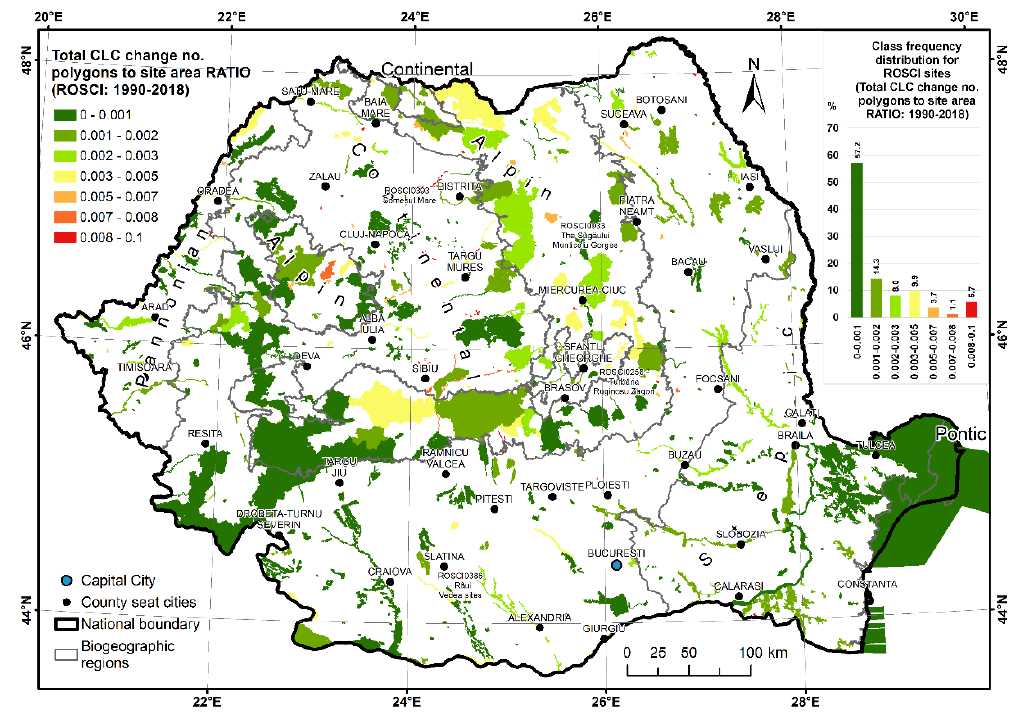
Figure 3. Changed polygon number to site area ratio for ROSCI (1990–2018).